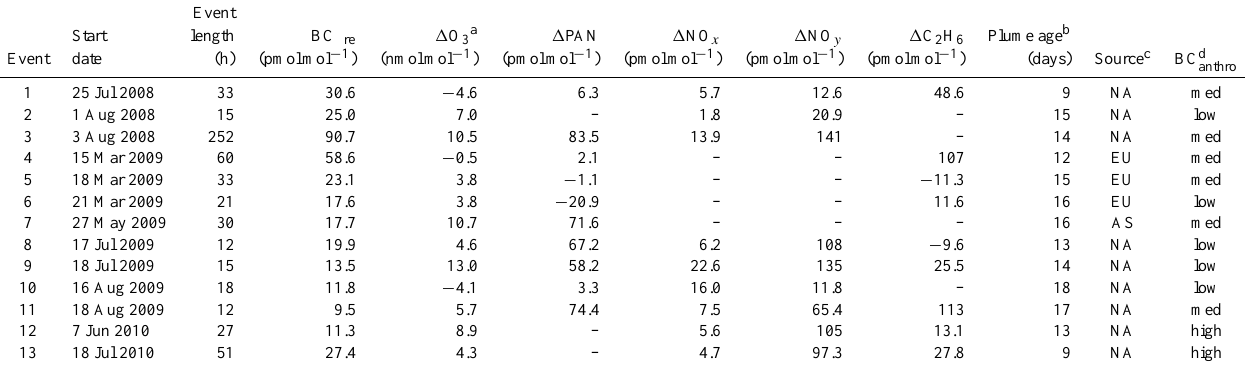
Table 3. Biomass burning events and mean enhancements in trace gases measured at Summit. Event Start length BC fire (cid:49) O 3a (cid:49)